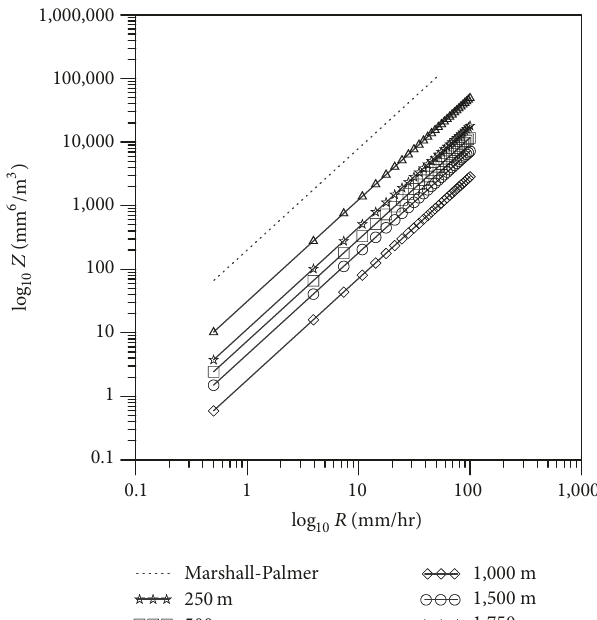
Figure 8: 𝑍 - 𝑅 relationships estimated for each altitude zone.